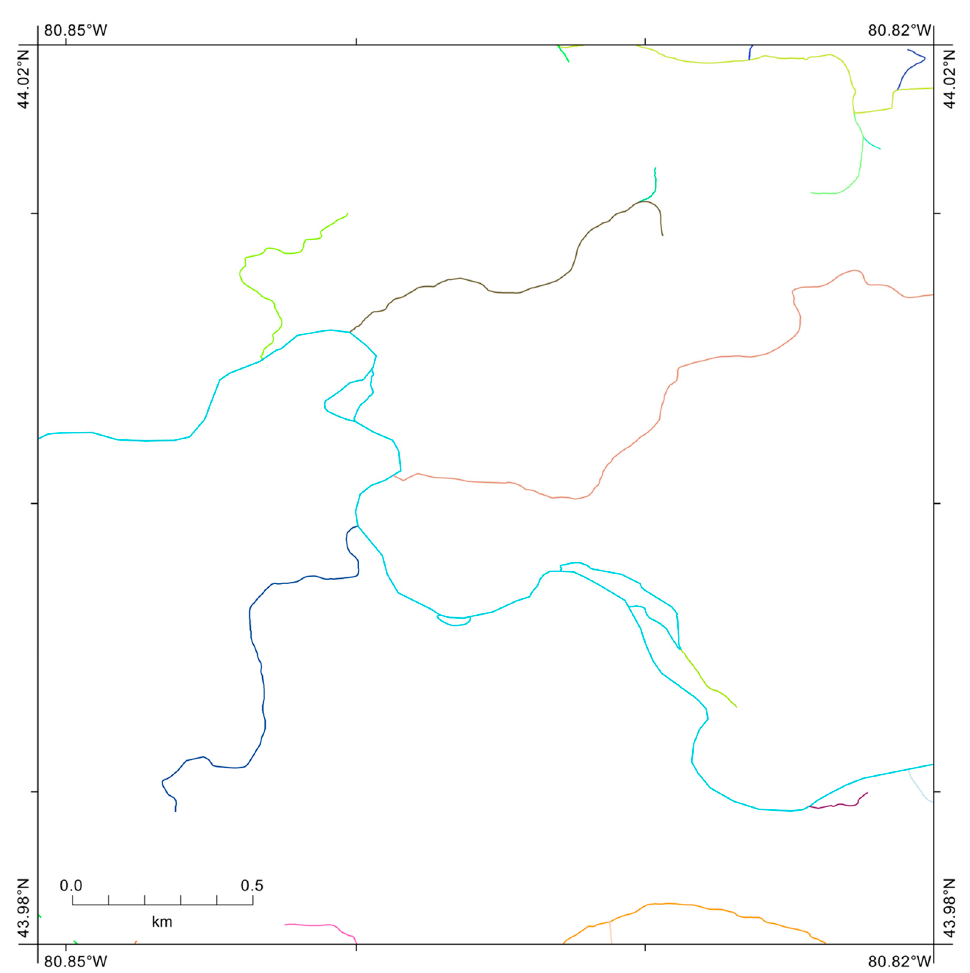
Figure 7. Tributary identifier values (designated by random colors) assigned to a braided reach of the Saugeen River, Ontario, and some of its minor tributary streams. Notice the three small braided sections situated along the main (light blue) river.